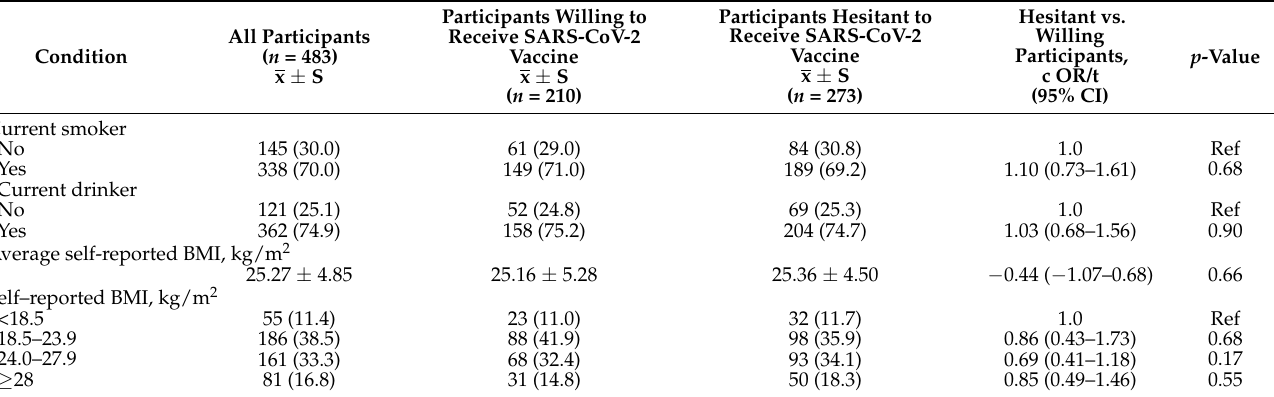
Table 2. Lifestyle and health conditions of study